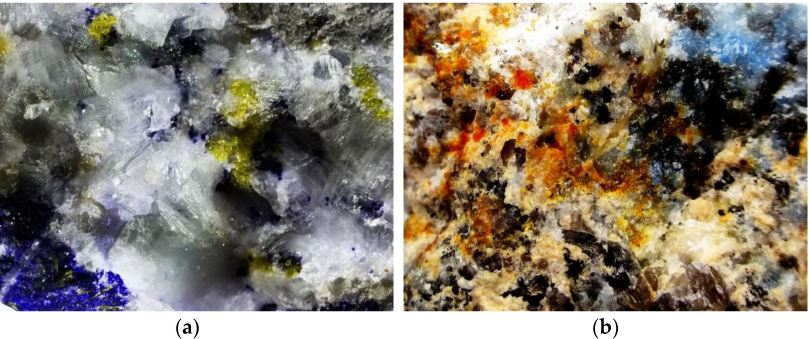
Figure 1. Grains of ( a ) bystrite (Sample 9, yellow) in association with lazurite (deep blue) and calcite (white) and ( b ) sulfhydrylbystrite (red–orange) in association with afghanite (pale blue), diopside (dark grayish green to almost black), nepheline (grey), plagioclase (yellowish to beige) and calcite (white). The field of view (FOV) widths are ( a ) 16 mm and ( b ) 20 mm.